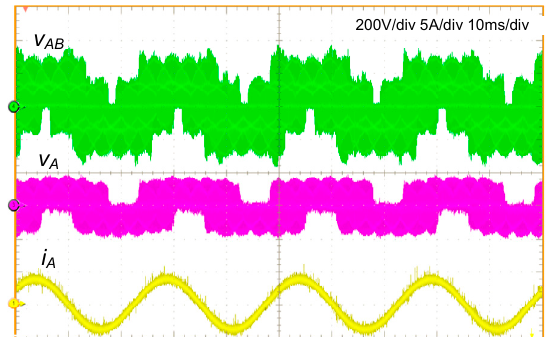
Figure 18. Experimental results of load side: line-to-line output voltage, phase output voltage and output current.